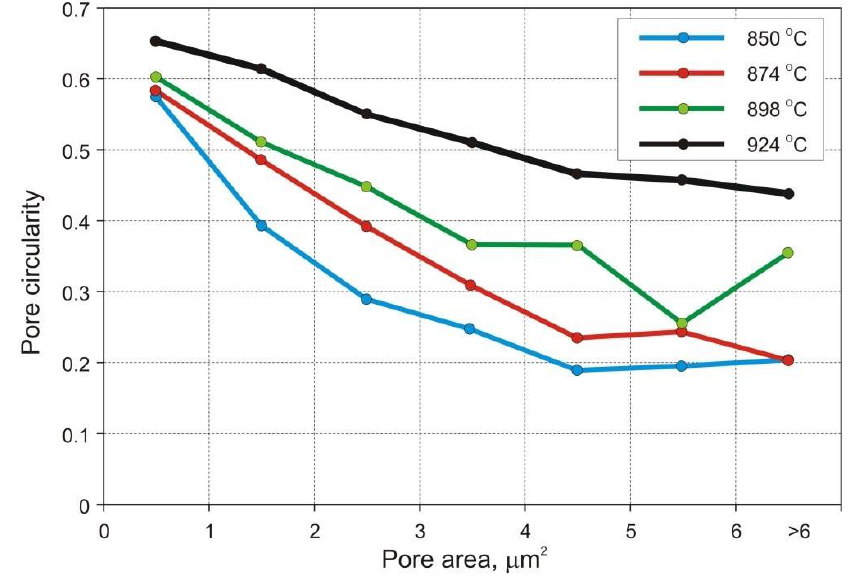
Figure 8. Pore circularity as a function of pore area.